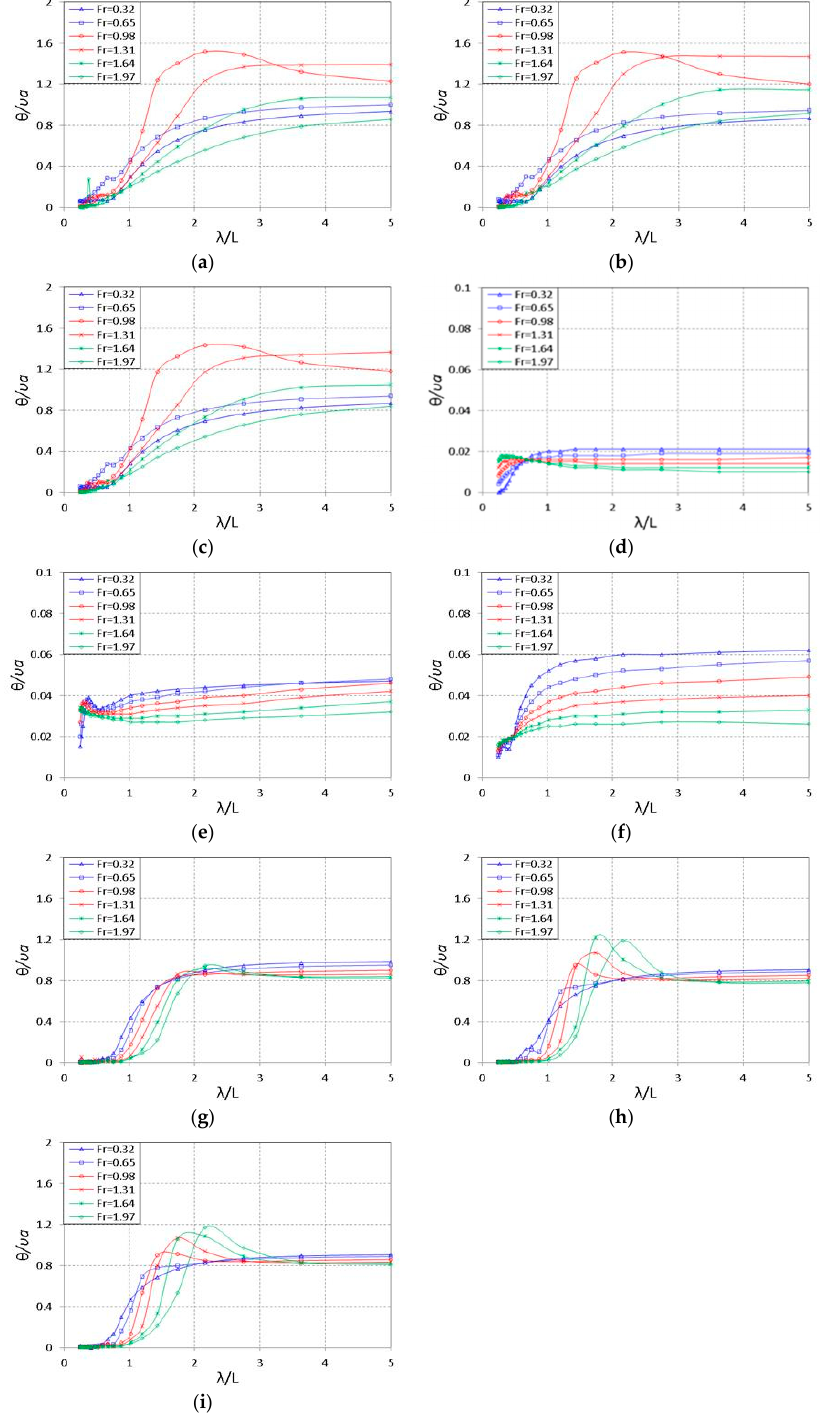
Figure 9. RAO comparison of pitching motion for various Froude numbers and trim angles of ( a ) τ = 0 ◦ , ( b ) τ = 1 ◦ , or ( c ) τ = 2 ◦ when µ = 0 ◦ ; ( d ) τ = 0 ◦ , ( e ) τ = 1 ◦ , and ( f ) τ = 2 ◦ when µ = 90 ◦ ; and ( g ) τ = 0 ◦ , ( h ) τ = 1 ◦ , and ( i ) τ = 2 ◦ when µ = 180 ◦